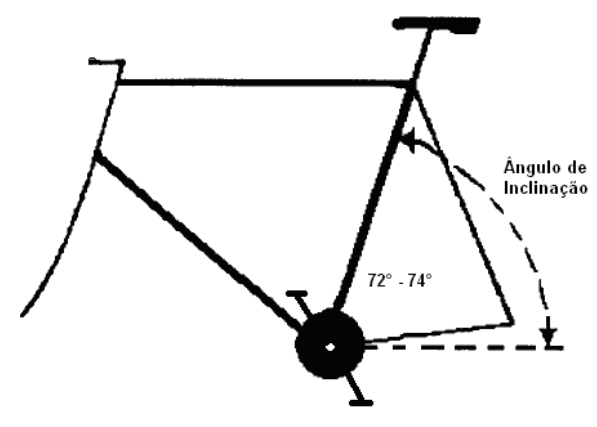
Figura 1. Representação esquemática do ângulo de inclinação do tubo do selim. Salai et al. (1999) objetivaram avaliar as possíveis causas da dor lombar em ciclistas e sugeriram uma solução para o ajuste apropriado da bicicleta. Foram avaliados ciclistas em três tipos de bicicletas. A angulação pélvica e